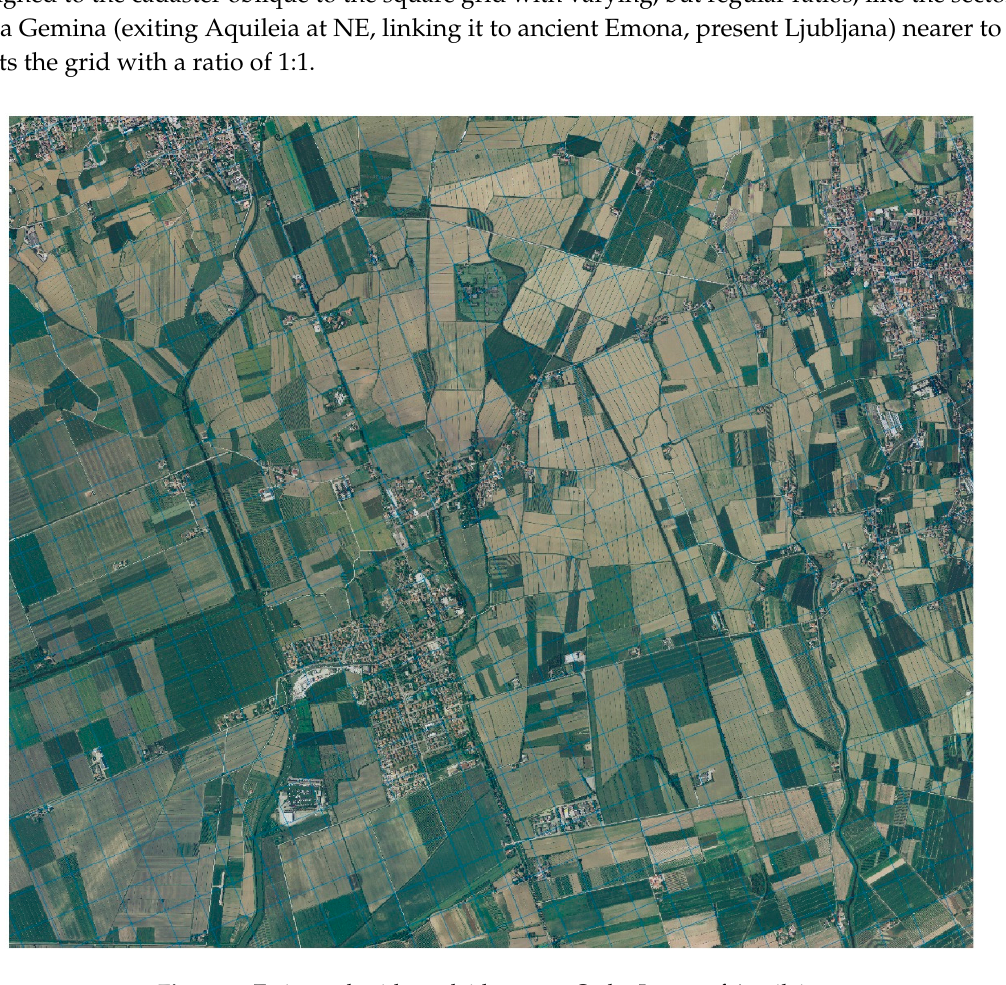
Figure 9. Estimated grid overlaid over an Ortho Image of Aquileia.